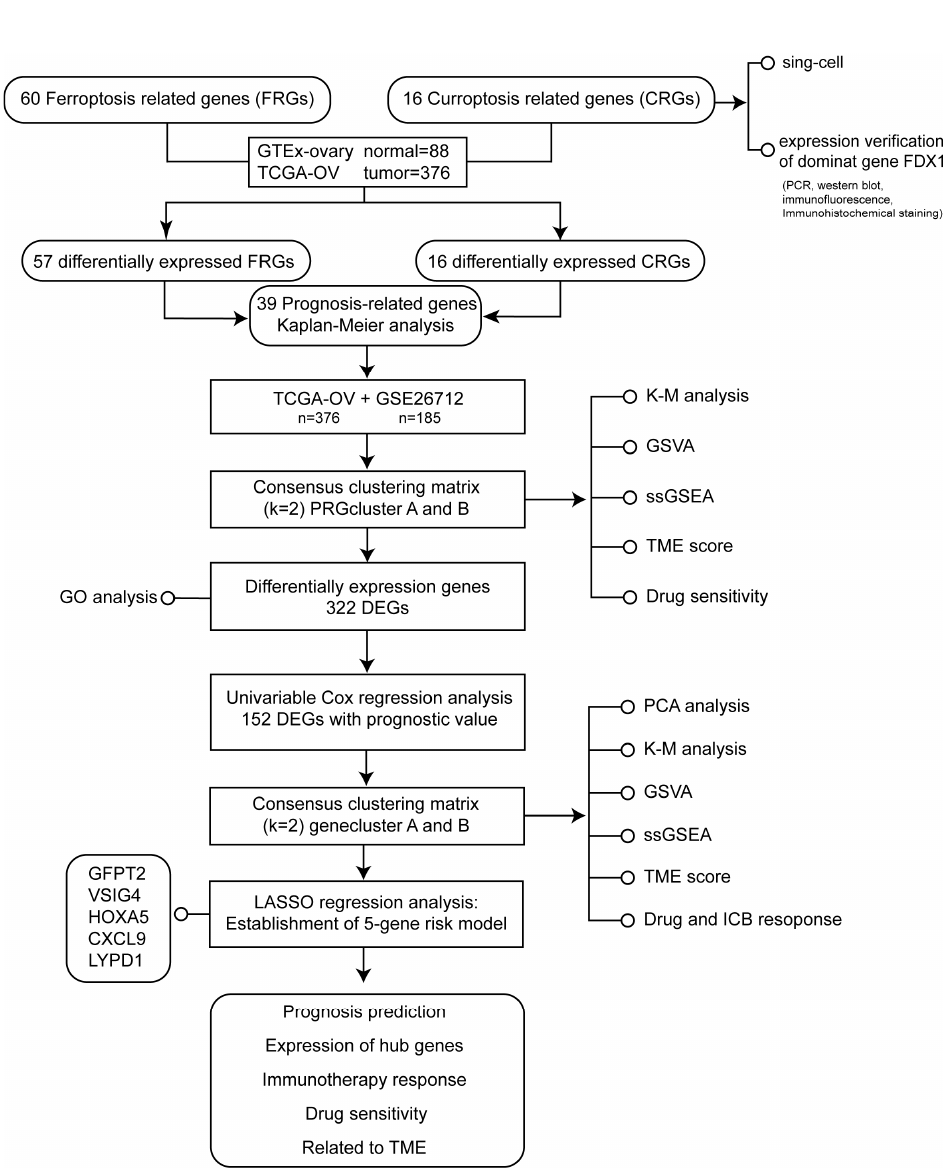
Figure 1. The flowchart of the study design.